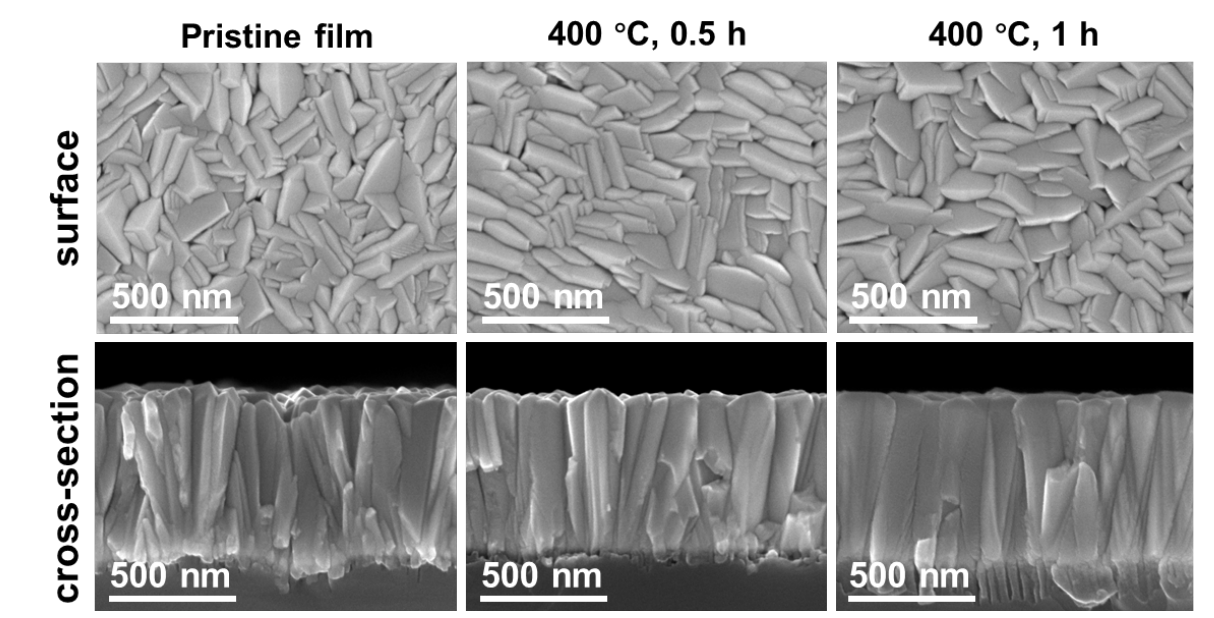
Figure 9. Surface and cross-section SEM images of the WTi alloy film with 6.8 at.% Ti after vacuum annealing at 400 °C for 0~1 h.